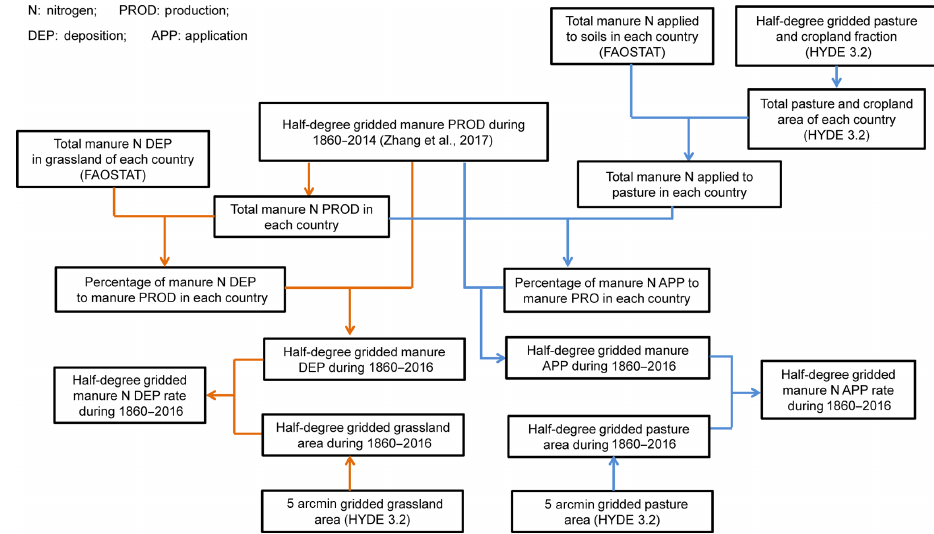
Figure 2. Diagram of the workflow for developing the database of global annual manure N use rate in pastures and manure N deposition rate in pastures and rangelands during the period 1860–2016.